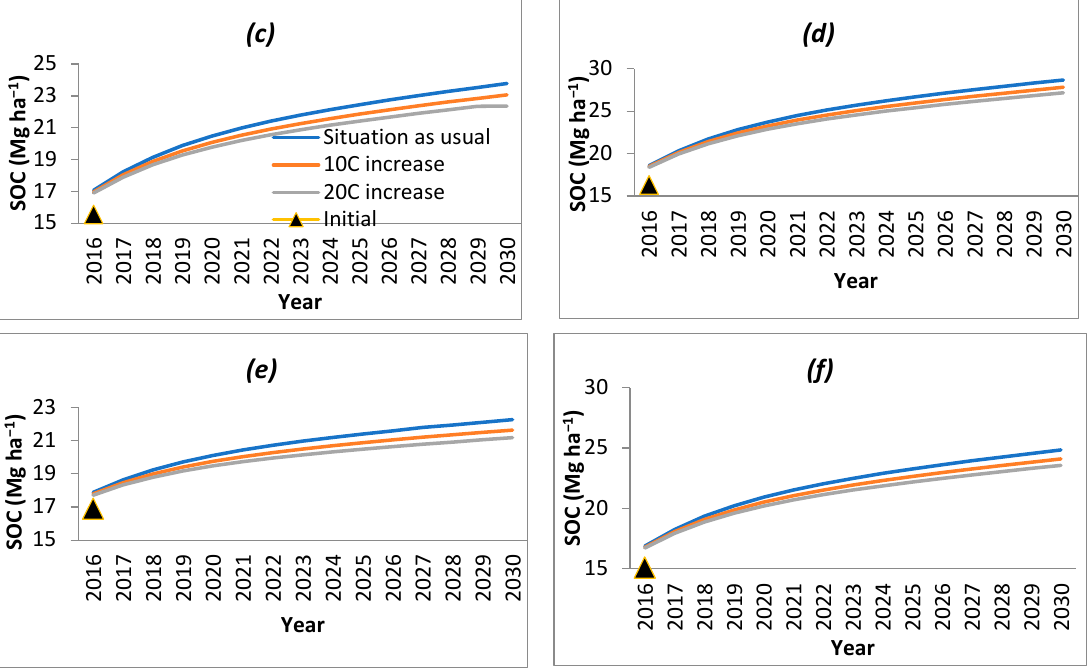
Figure 4. SOC variation as a result of increase in temperature in ( a ) B. balcooa , ( b ) B. bambos, ( c ) B. nutans , ( d ) D. hamiltonii , ( e ) D. stocksii and ( f ) D. strictus .